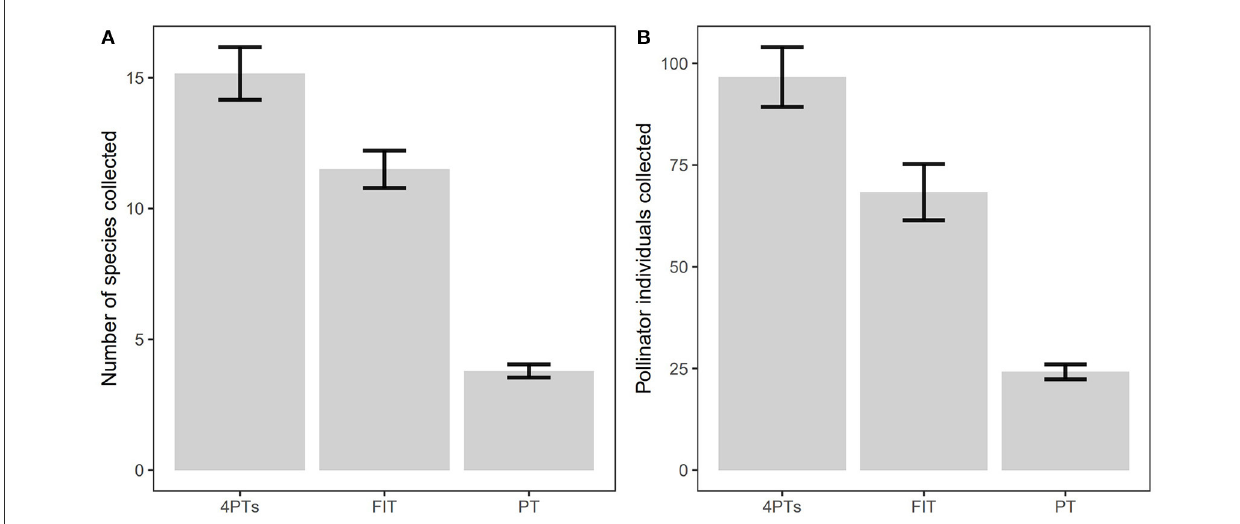
FIGURE3 Number of species (A) and (B) pollinator individuals collected by a FIT, a single PT and four PTs combined (4PTs).